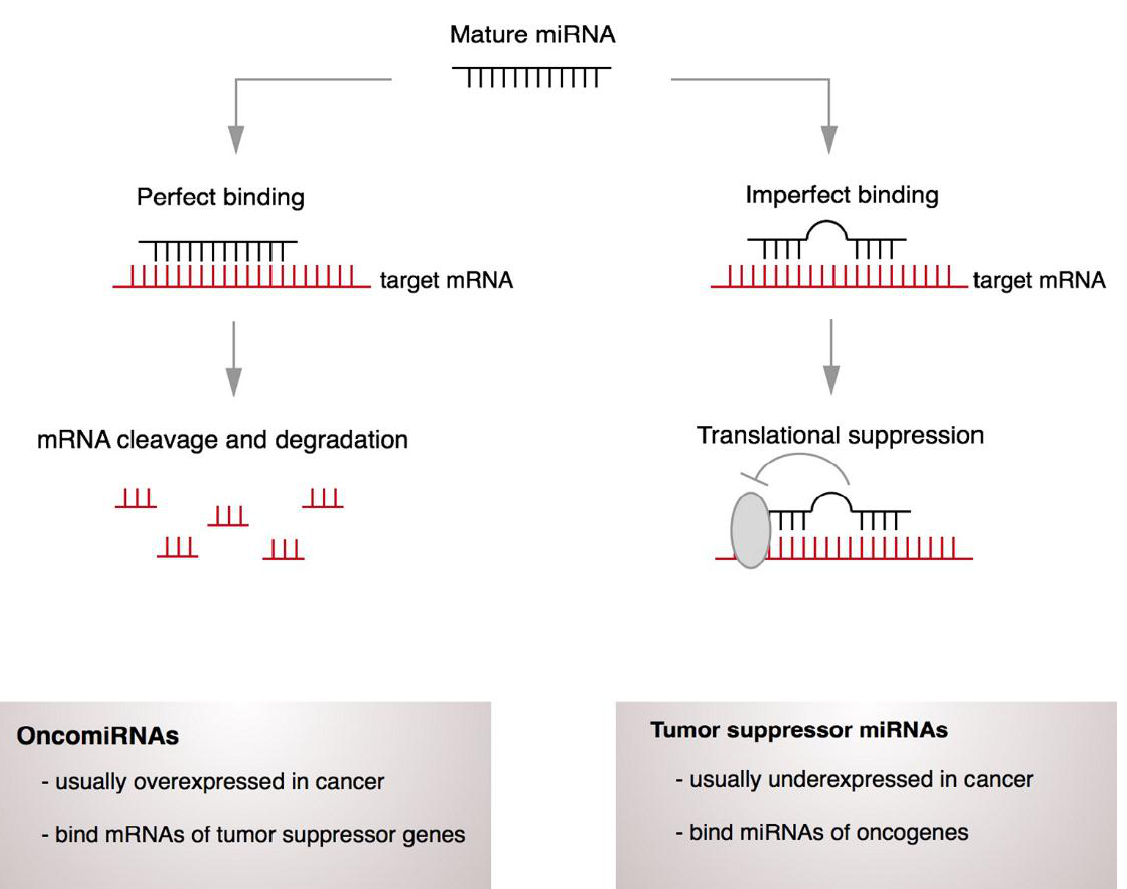
Figure 1. Mechanism of miRNA action. MiRNA can bind to specific regions of target mRNA transcripts and destabilizes the target transcript and/or blocks its